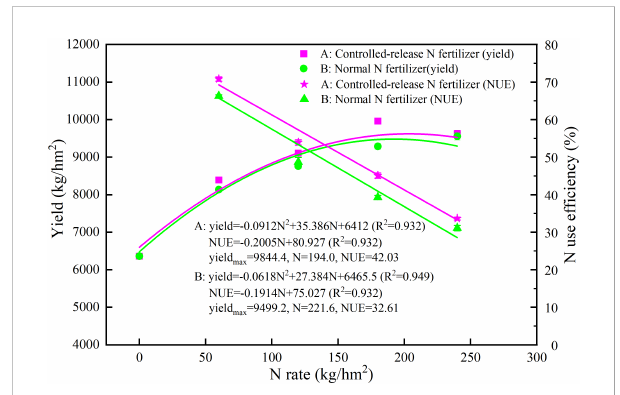
FIGURE 5 Average yield and N use ef fi ciency (NUE) of rice from 2016 to 2020 under the blended CRN treatments (red graph) and conventional N fertilizer treatments (green graph) with applied N rates of 0, 60, 120, 180, and 240 kg/hm 2